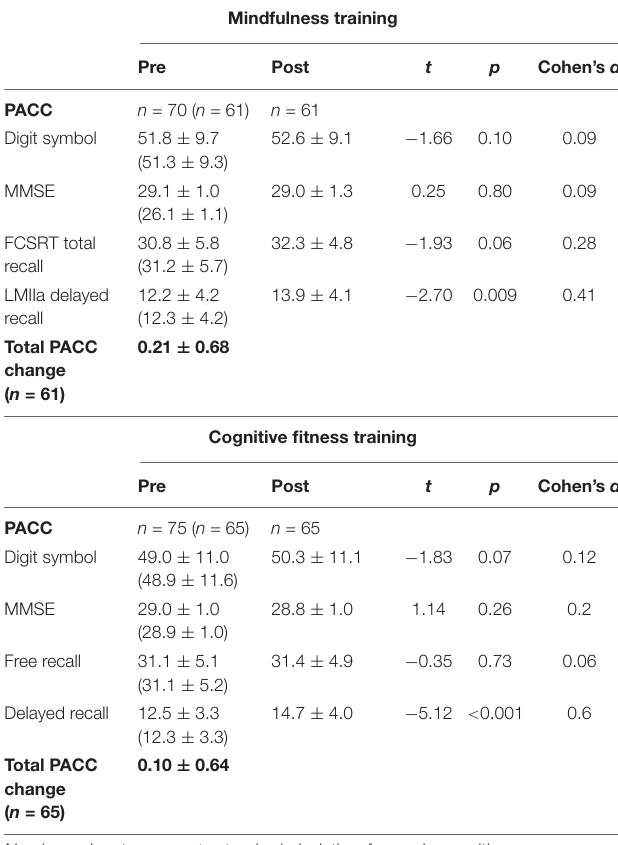
TABLE 2 | Cognitive outcome